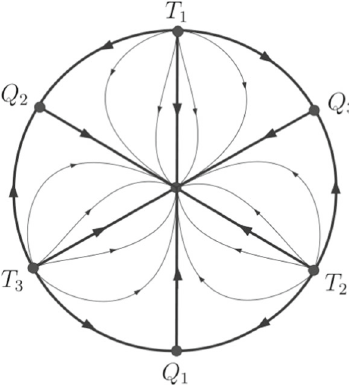
Fig. 2 The phase portrait in the Kasner disc ( (cid:2) ≤ 1) for − 1 ≤ w ≤ − 1 / 3. Any solution isotropizes towards the FLRW universe at the cen- ter. The T -Taub points are unstable nodes. The Q -Taub points are sad- dles up to the value w = − 1 / 3, when they coincide with the (cid:21) Q ’s and begin the transition to stable nodes. In this case, they are